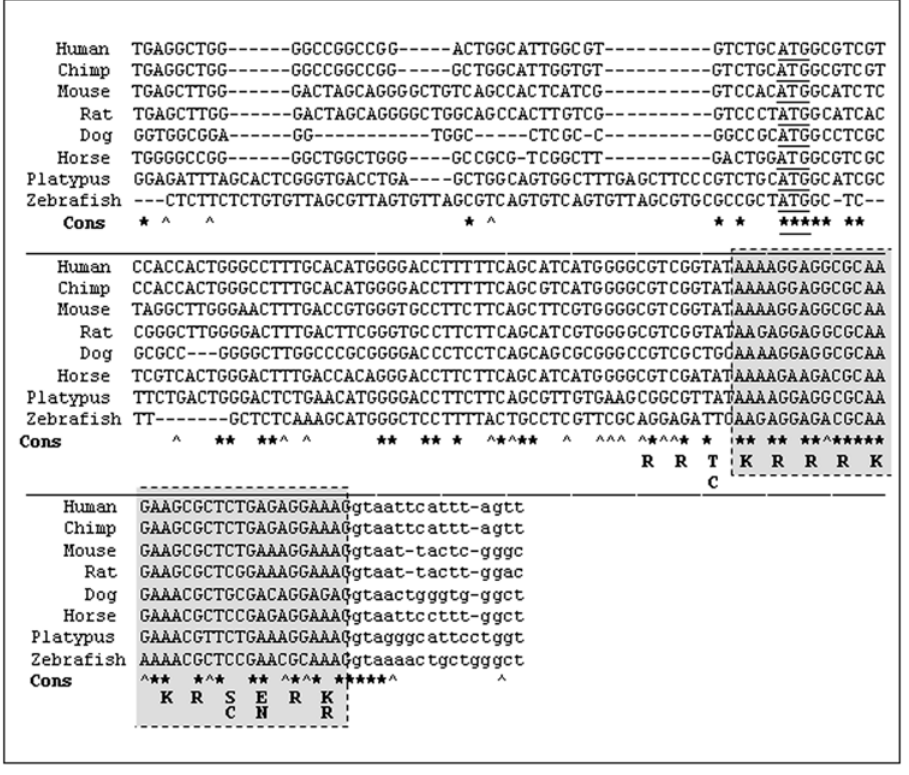
Figure 3. The R-domain and exon 0 are conserved across vertebrates. Vertebrate exon 0 sequence alignment including human, chimp, mouse, rat, dog, horse, platypus and zebrafish. The consensus track indicates residues conserved among all species with an asterisk (*) and those conserved in all higher vertebrates with a circumflex accent ( ‘ ). The nucleotide sequence of the R-domain including the translation is shaded; the translational start codon in underlined. The genomic locations of the aligned sequences are: UCSC version hg18, March 2006, chr21:45,396,913– 45,397,066 (Homo sapiens); UCSC version panTro2, March 2006, chr21:44,799,898–44,800,051 (Pan troglodytes); UCSC version mm8, February 2006, chr10:76,783,722–76,783,879 (Mus musculus); UCSC version rn4, November 2004, chr20:11,691,863–11,692,020 (Rattus norvegicus); UCSC version canFam2, May 2005, chr31:41,072,028–41,072,166 (Canis familiaris); UCSC version equCab1, February 2007, chr26:1,562,280–1,562,433 (Equus caballus); UCSC version ornAna1, March 2007, Ultra489:519,316–519,487 (Ornithorhychus anatinus); and NCBI assembly Zv7, July 2008, Chromosome 22, NW_001878325.1 (Danio rerio).